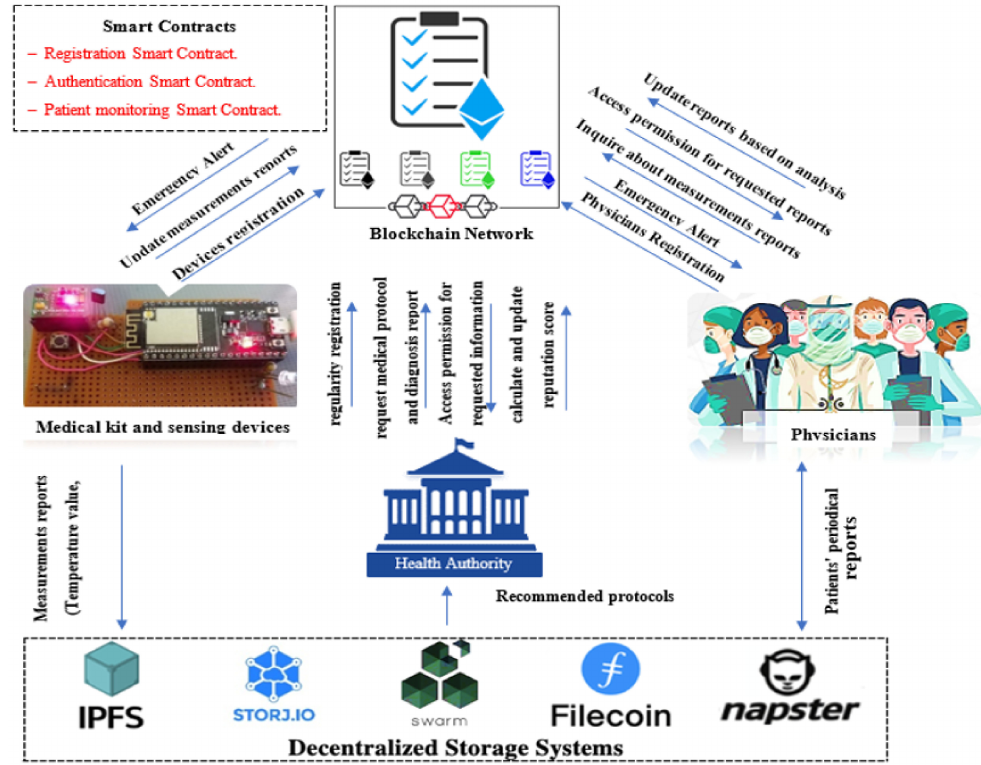
Figure 14. A high-level architecture for the proposed blockchain-based system for the pharmaceutical supply